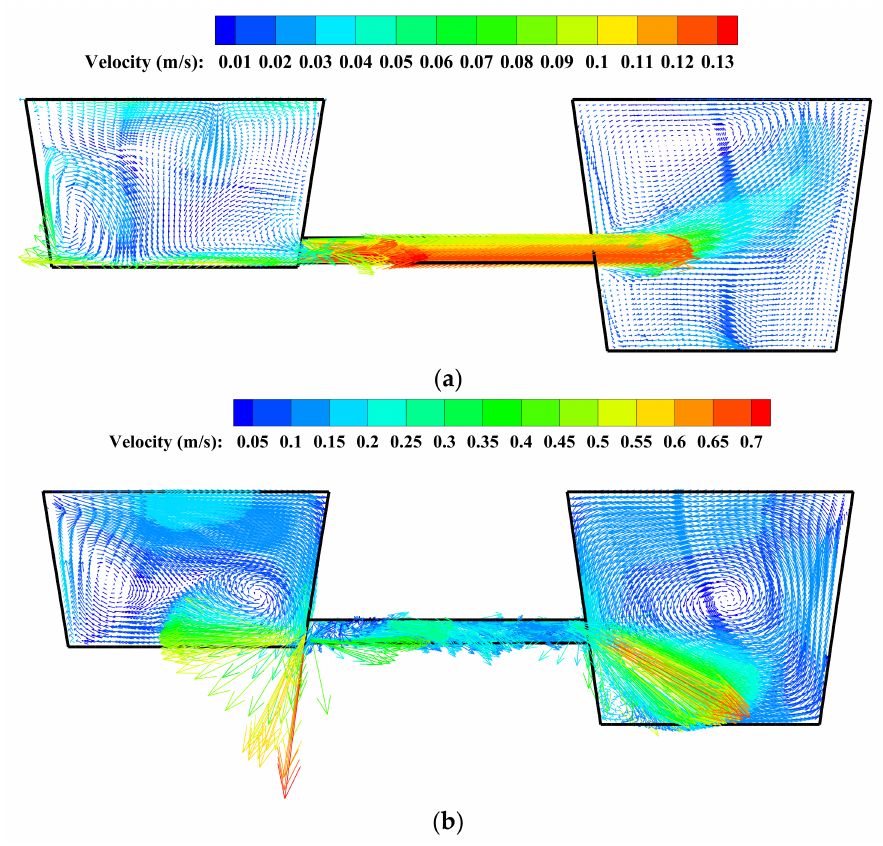
Figure 5. Velocity vector in the tundish with and without channel induction heating. ( a ) Without induction heating, × = − 0.379 (YZ plane); ( b ) With induction heating, × = − 0.379 (YZ